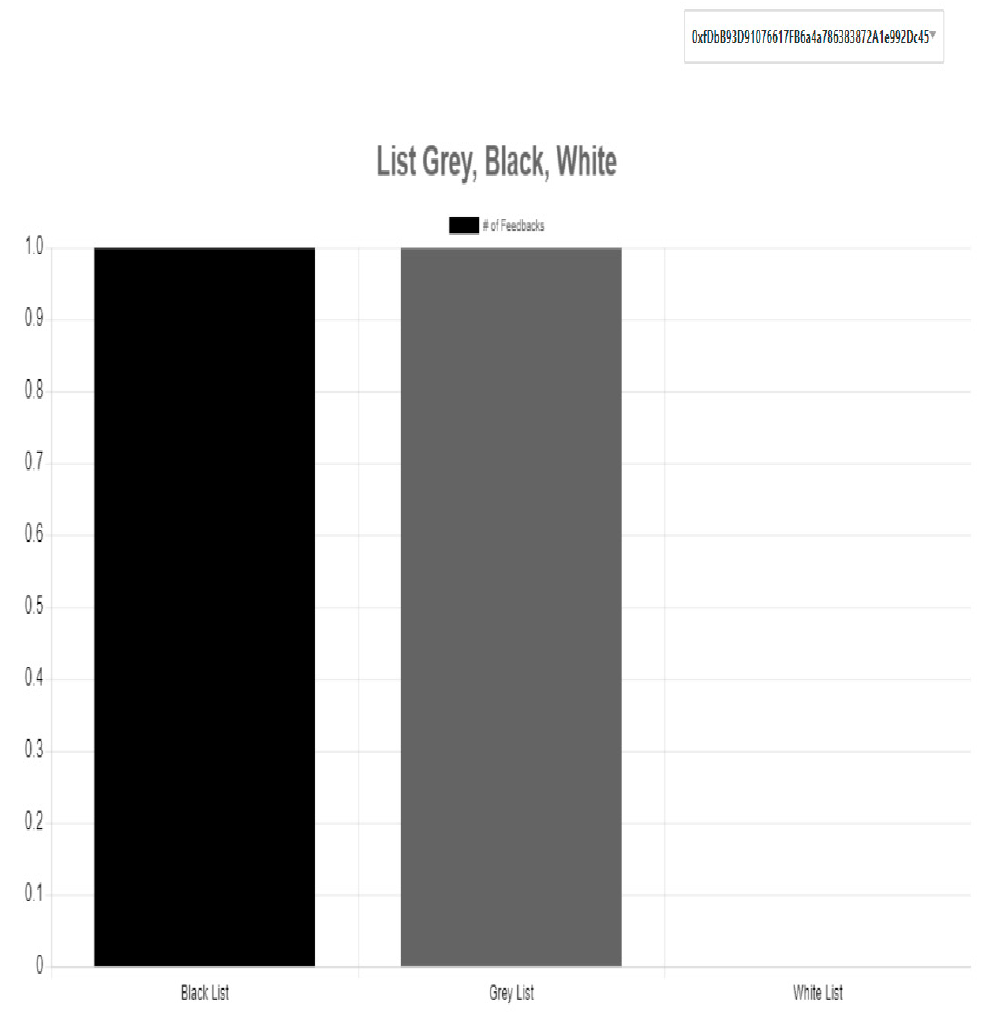
Figure 11. Variation in SP status based on the Reputation Values for SP4.